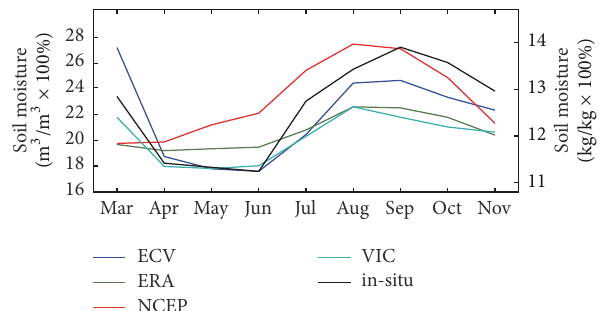
Figure 3: Seasonal variations of the five used soil moisture datasets for the period of 1988–2010, which are spatially averaged in the selected typical study